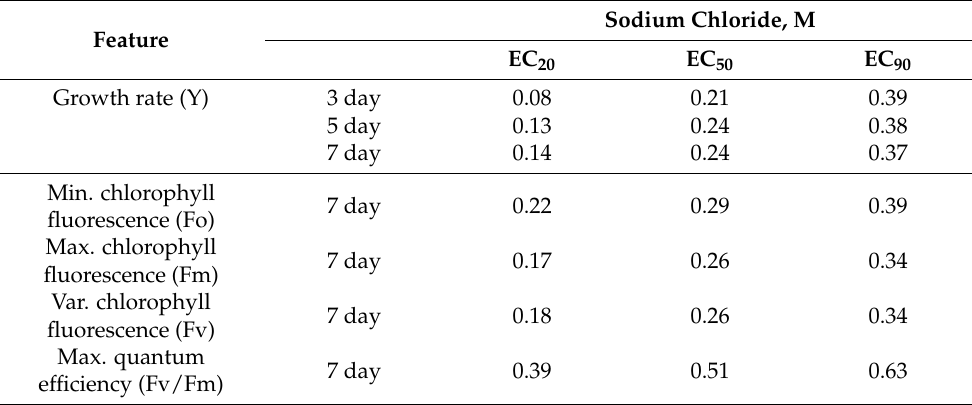
Table 3. Effect of sodium chloride (NaCl) on growth rate (Y), minimum chlorophyll fluorescence (Fo), maximum chlorophyll fluorescence (Fm), variable chlorophyll fluorescence (Fv) and maximum quantum efficiency (Fv/Fm) of algae Pseudokirchneriella subcapitata